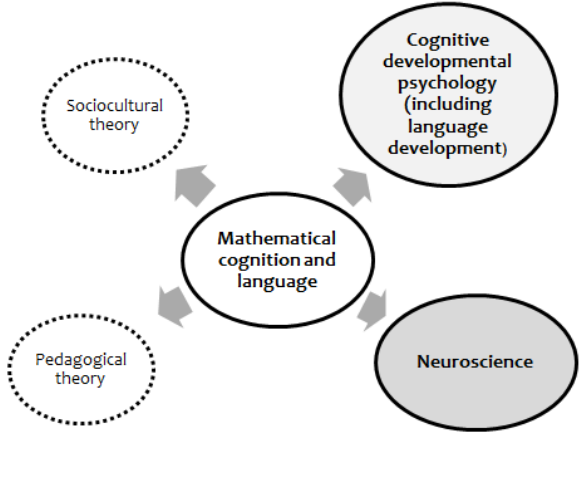
Figure 1: Nodes in an integrated a theoretical network for mathematical cognition and language